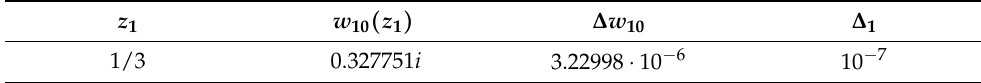
Table 3. Numerical characteristics of example